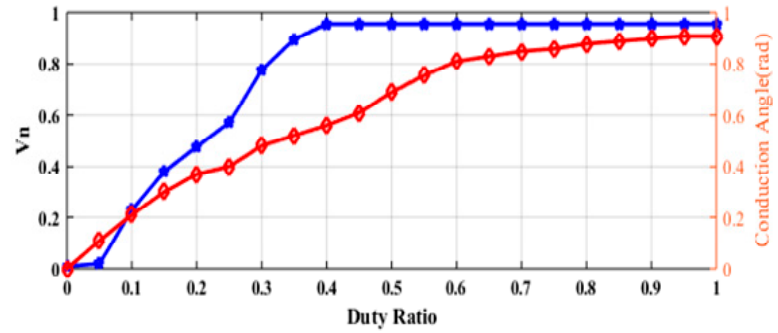
Figure 4. PA efficiency versus duty ratio.